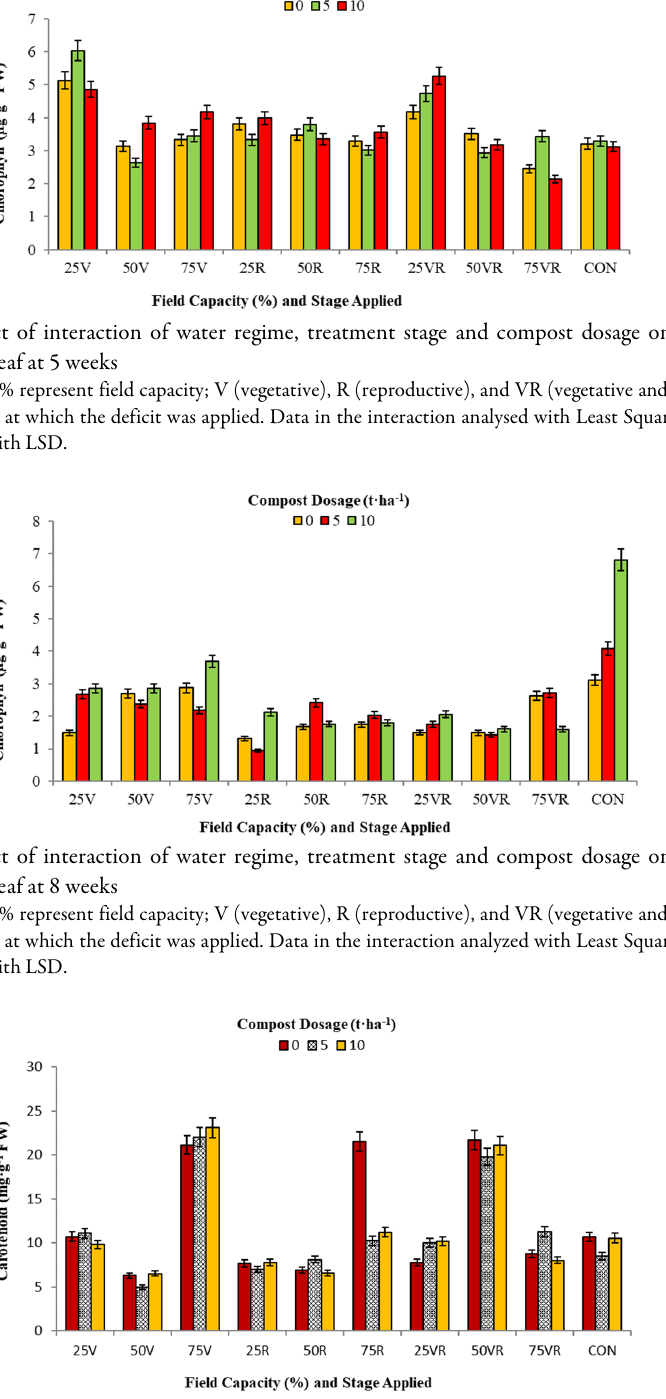
Figure 15. Effect of interaction of water regime, treatment stage and compost dosage on carotenoid content of okra leaf at 5 weeks The 25, 50 and 75% represent field capacity; V (vegetative), R (reproductive), and VR (vegetative and reproductive) represent the stage at which the deficit was applied. Data in the interaction analysed with Least Squares Means, and means separated with